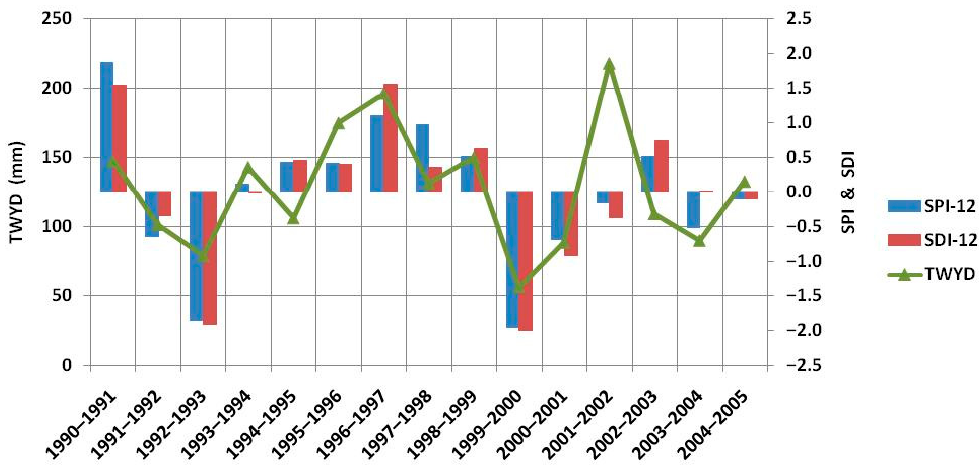
Figure 8. Annual distribution of historical Total Water Yield (TWYD), SPI-12, and SDI-12.